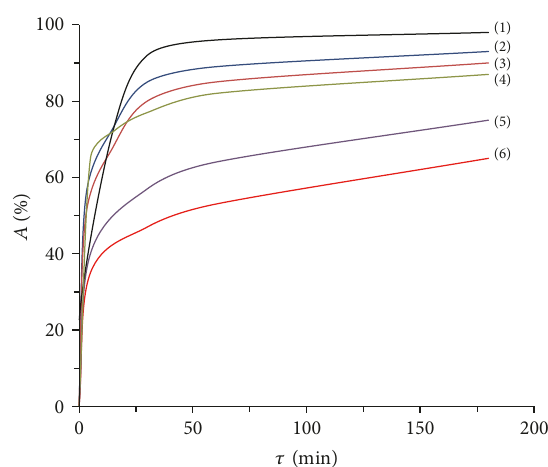
Figure 6: Kinetic curves of MMA polymerization in the presence of PVP-gr-PMMA depending on nature and content of comonomer and filler. Comonomer: (2) HEMA, (3) GMA, and (4) VP. Filler: (5) Al (6) SiO 2 O 3 , and 2 . Comonomer content: 20% (mas.). Filler content: 10%